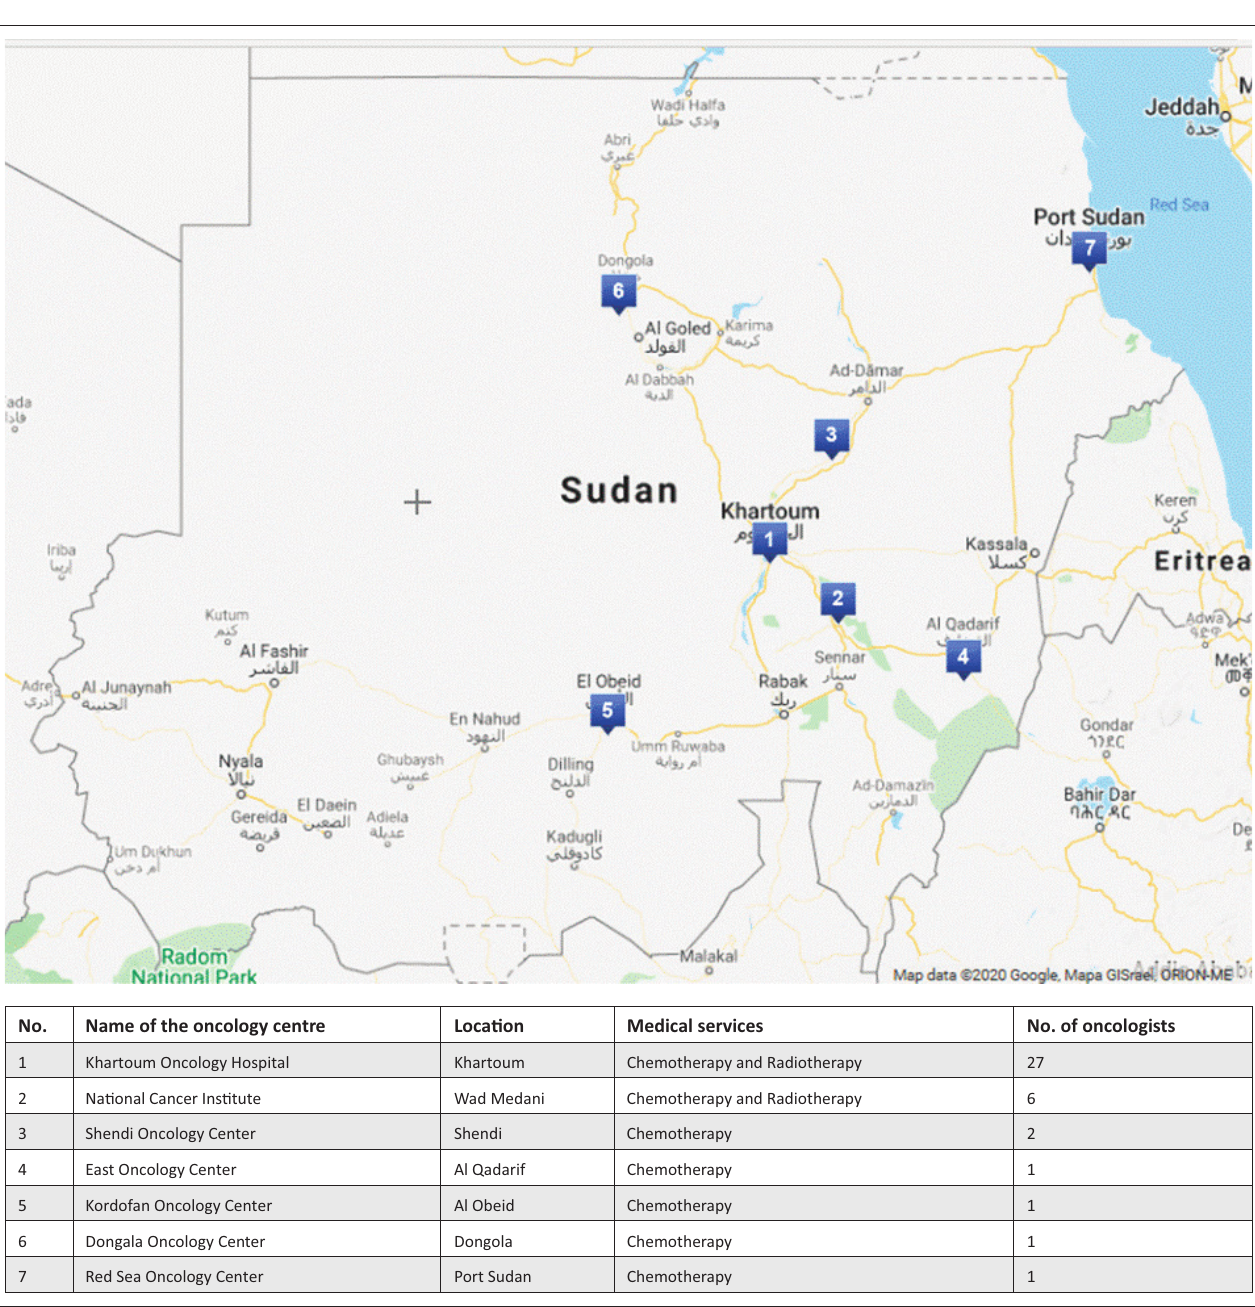
FIGURE 1: Geographic distribution of cancer treatment centres in Sudan.